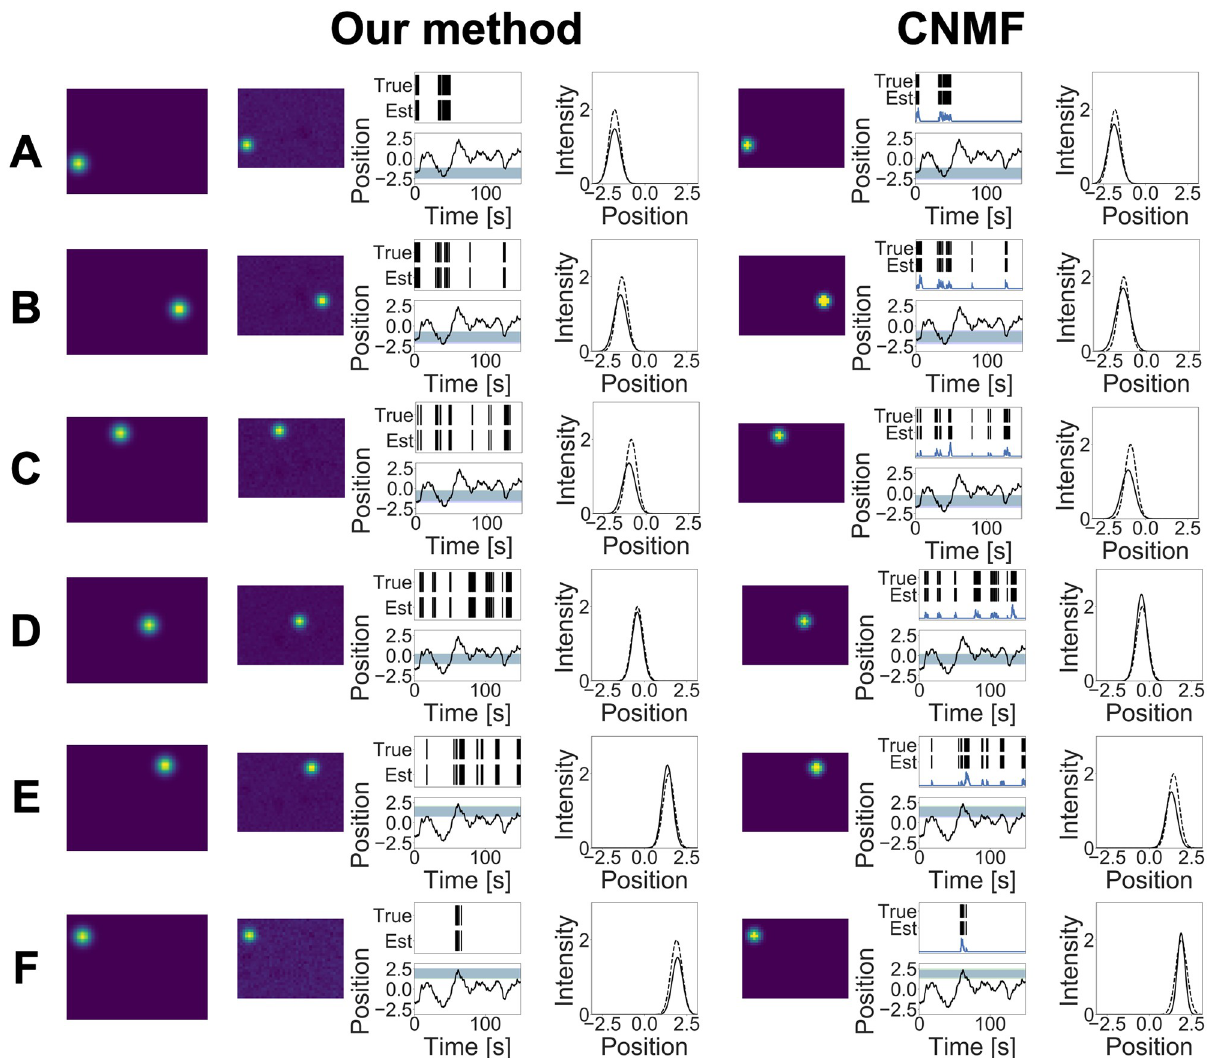
Fig 3. (A)–(F) Estimation results obtained by two methods in the simulation study. The first column indicates the ground truths, the second column shows components obtained by our method, and the third column shows components obtained by CNMF. Each component consists of three figures. (Left) Estimated cell shape. (Middle) Estimated spike train. The vertical lines indicate when spikes occurred; the upper lines indicate true spikes, and the bottom lines indicate estimated spikes. The black line plot shows the external stimulus. The green band shows the receptive field decided by the true μ x and τ x , and the blue band shows the receptive field decided by the estimated values. (Right) Tuning curve. The solid line shows the estimated tuning curve, and the dashed line shows the true tuning curve with the mean value closest to the estimated mean value m x k